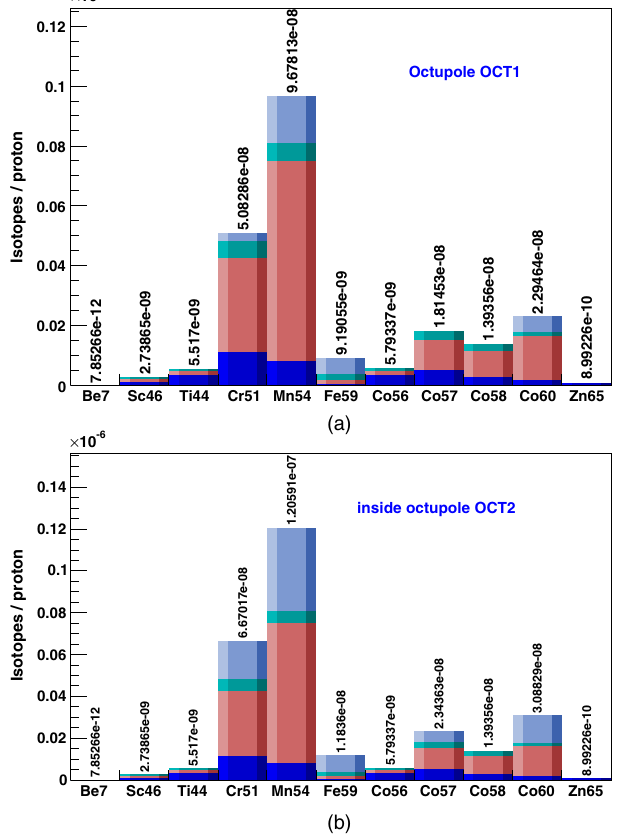
FIG. 6. The radionuclide inventory for the HEBT-S3 octupoles: (a) octupole OCT1, (b) octupole OCT2. The colors represent isotopes produced by backscattered neutrons from the target (blue), isotopes produced in direct proton interactions (dark blue), isotopes produced in secondary neutrons interactions (red), isotopes produced in other secondaries interactions